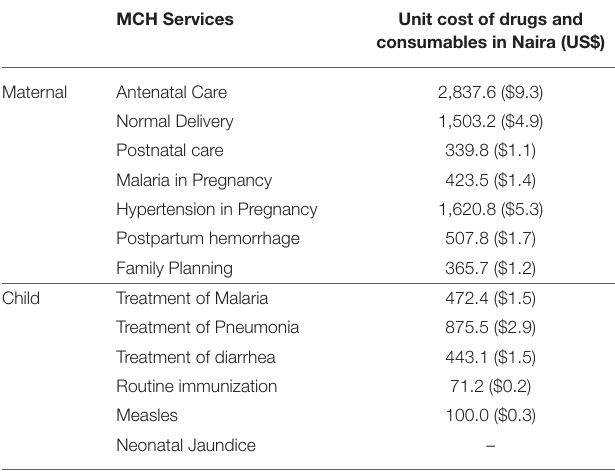
TABLE 5 | Unit costs for Drugs and Consumables for MCH services in the PHC